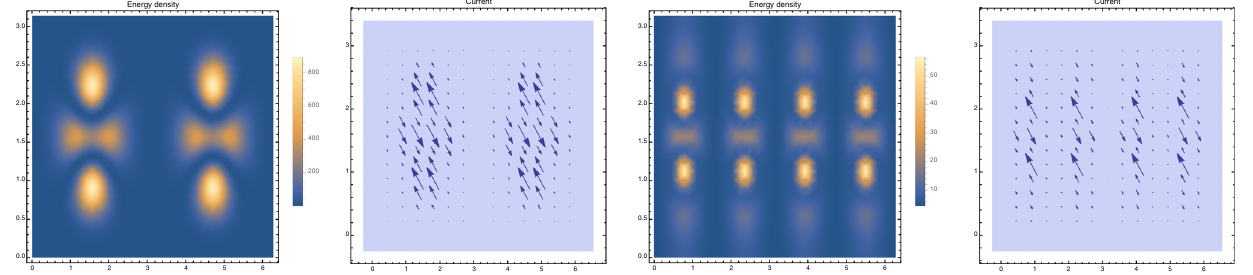
vanishes outside the tubes. The maximum values of E and the current coincide in the lattice, which is periodic in r , θ and perpendicular to the φ direction, along which the strings